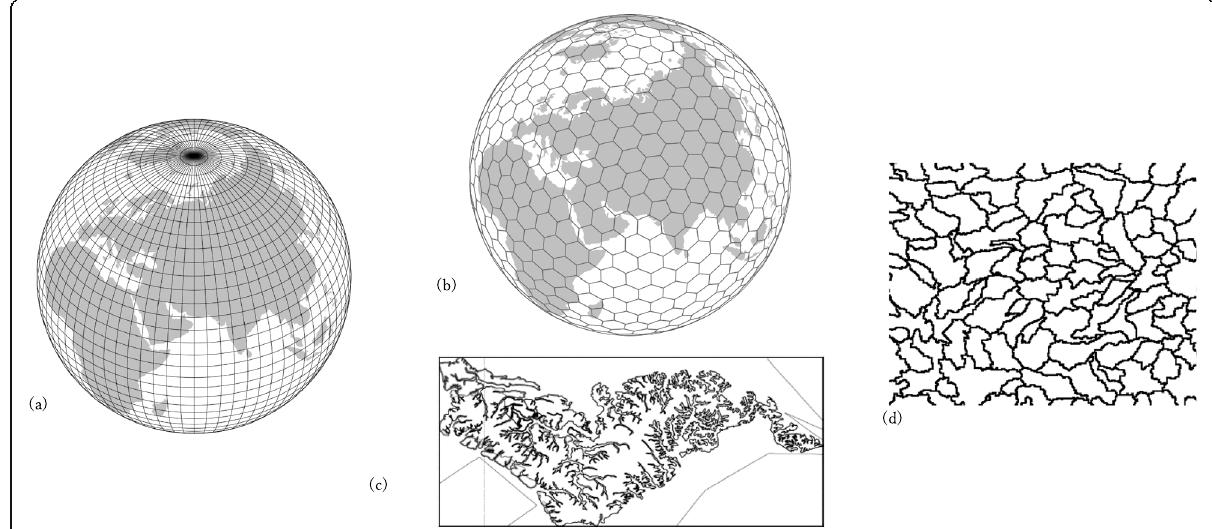
Fig. 4 Examples of grids to which SPRING is applicable. a Latitude – longitude grid, b NICAM grid (Satoh et al. 2008), a type of convex polygon grid, c concave polygon grid, and d basin-shaped grid, a type of grid defined by the aggregation of tiny